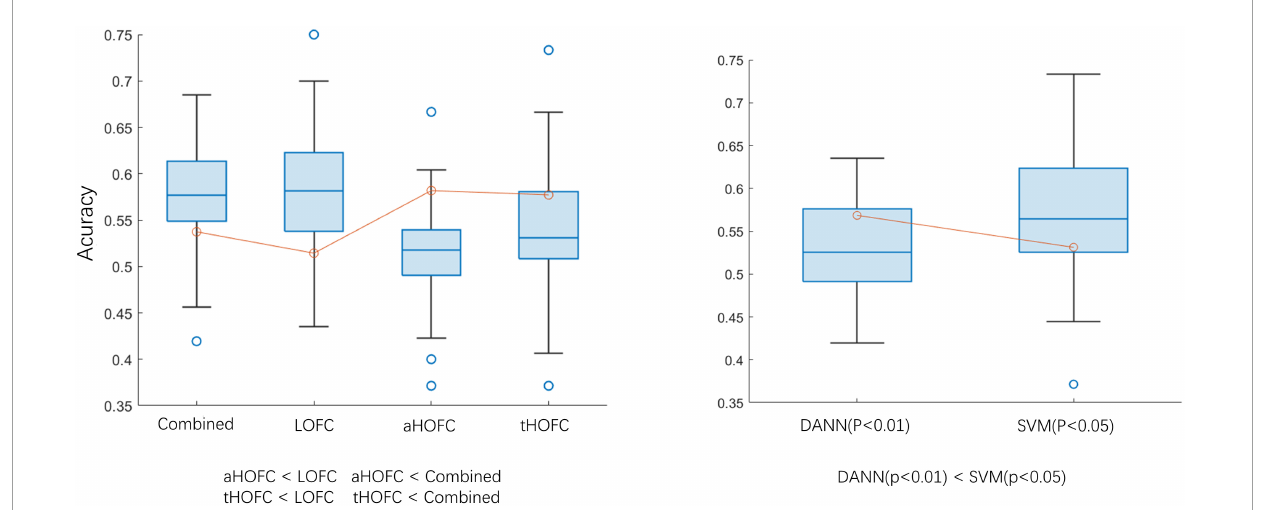
FIGURE5 Classification accuracy comparison. aHOFC: all classification results based on aHOFC; tHOFC: all classification results based on tHOFC; LOFC: all classification results based on LOFC; Combined: classification result of three network features fusion. DANN ( p < 0.01): using DANN as a classifier, the p -value of feature selection is 0.01; SVM ( p < 0.05): using SVM as the classifier, the p -value of feature selection is 0.05. The inequalities represent statistical differences between the two groups of data.